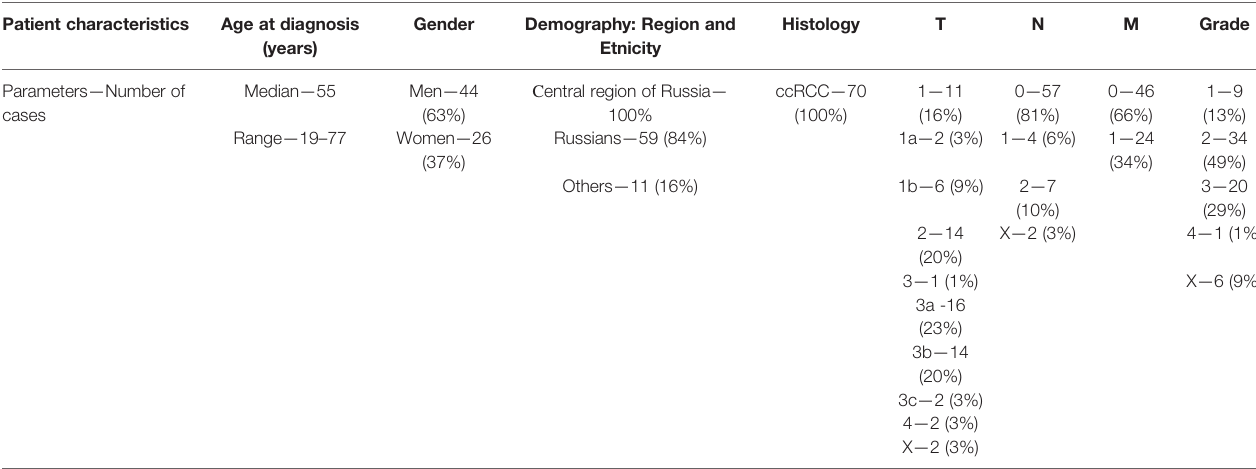
TABLE 1 | Patient